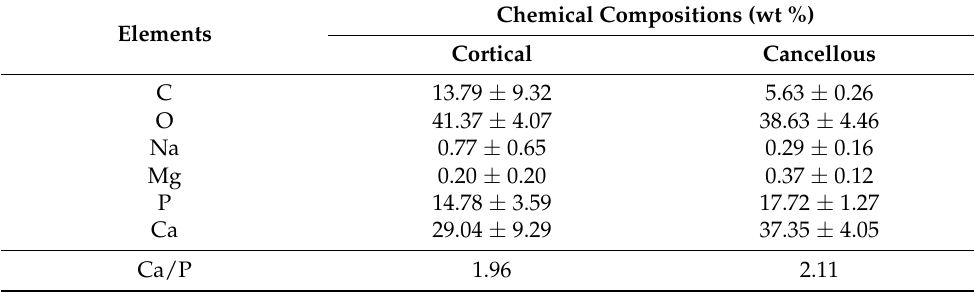
Table 1. Energy-dispersive X-ray spectroscopy (EDS) (%).